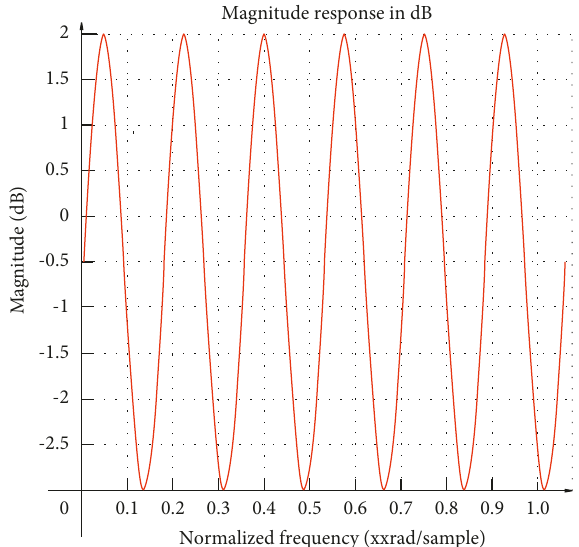
Figure 6: Example of long-time